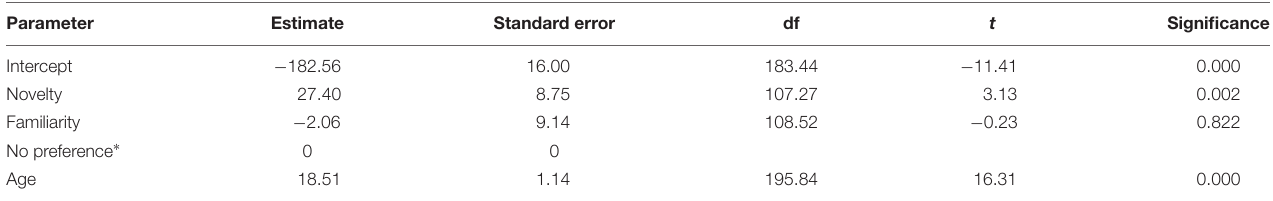
TABLE 2 | Fixed effects model